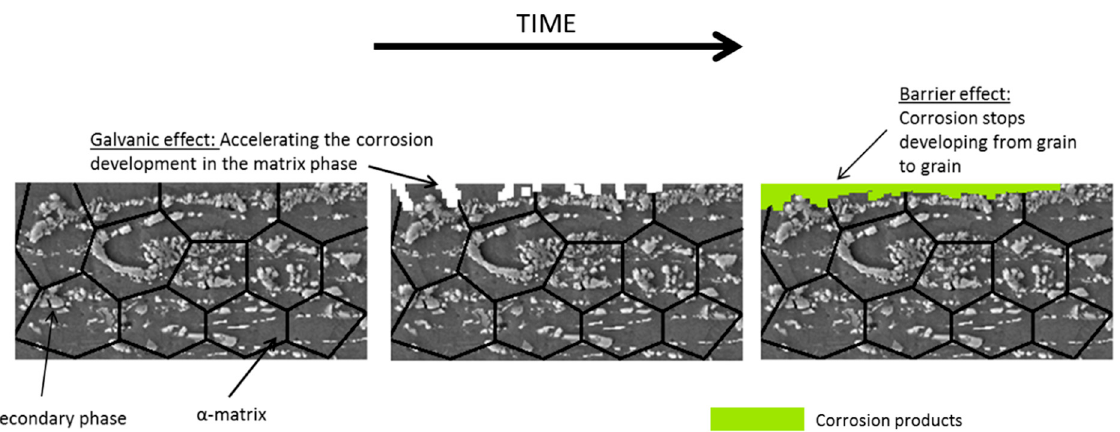
Figure 10. Schematic diagrams of morphology during the corrosion process .